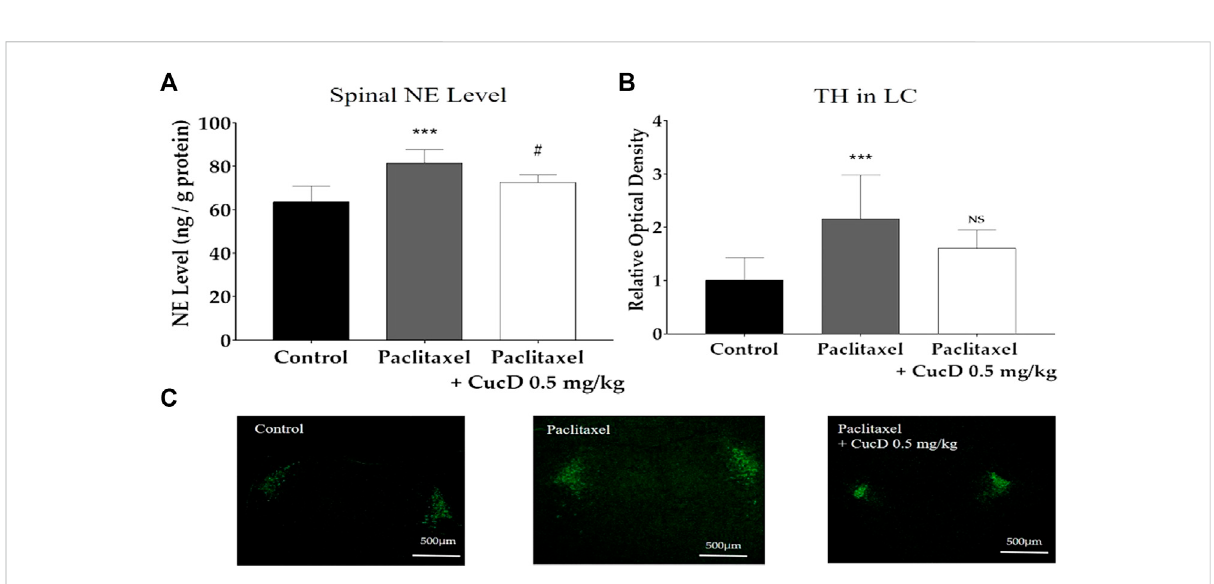
FIGURE 8 Expression levelsoftyrosinehydroxylase(TH)proteinimmuno fl uorescenceinmousebrainsandnoradrenalinecontentinthespinalcord.Brain sectionswere fi xedandstainedwiththeanti-THantibody.TheadministrationofpaclitaxelandcucurbitacinDchangedthenoradrenalinelevelinthe mouse spinal cord (A) . Relative intensity of TH protein productionin mouse brains (B) and the image is representative of theslides ofeach group (C) . N = 6 in each group. *** p < .001 vs. control and # p < .05 vs. paclitaxel with one-way ANOVA, followed by Tukey ’ s post-test for multiple